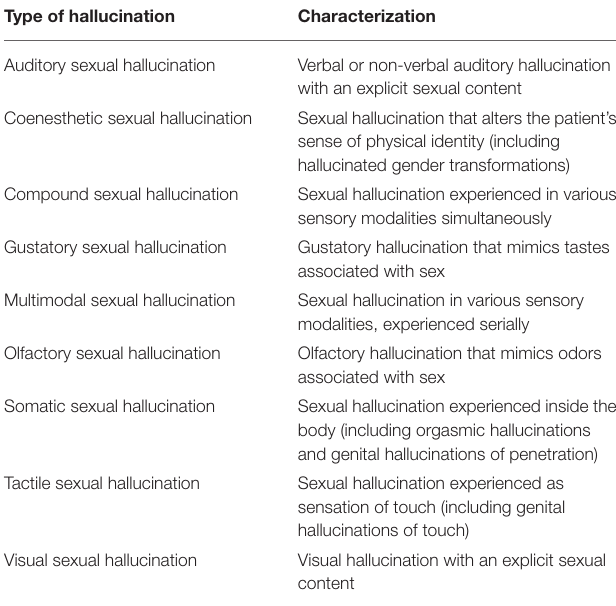
TABLE 4 | Classification of sexual